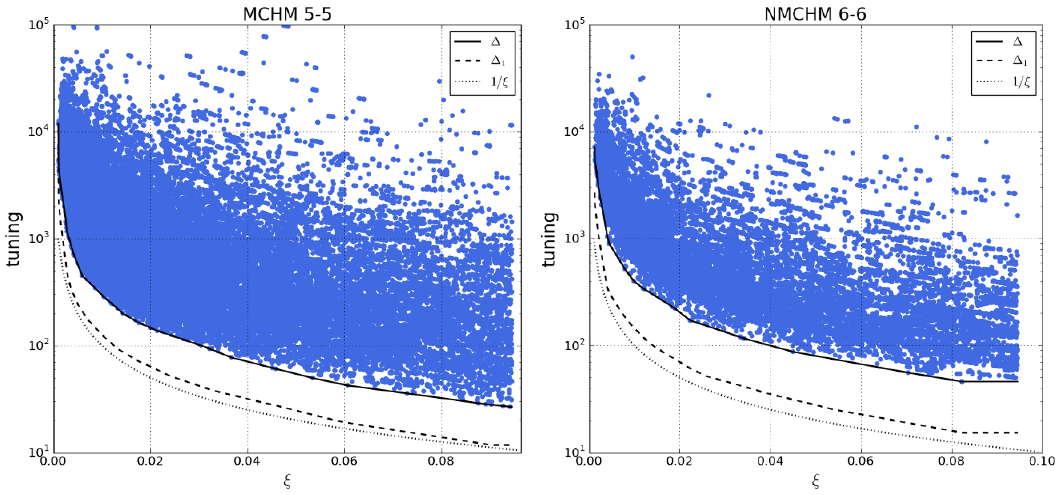
Figure 11. Comparison of vacuum misalignment vs higher-order tuning, between